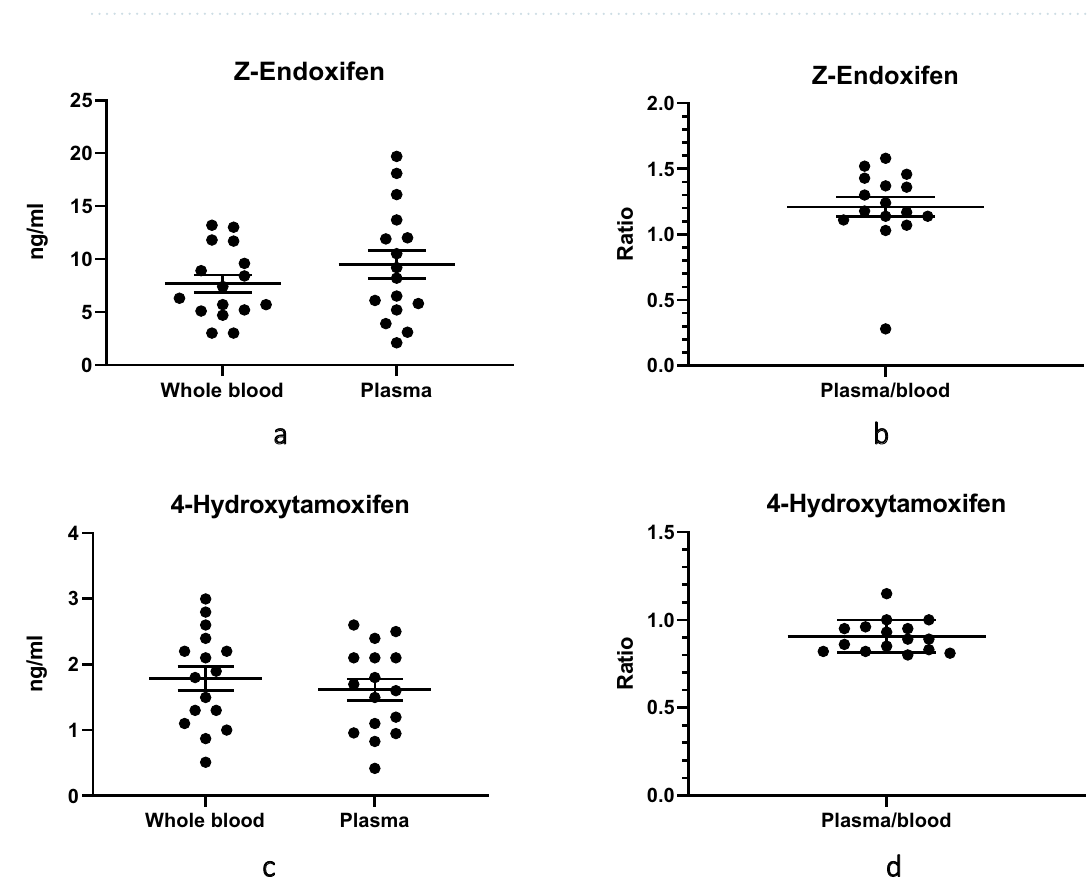
Figure 2. Z-endoxifen (END) and 4-Hydroxytamoxifen (4HT) concentrations in 16 participants with breast cancer taking tamoxifen 20 mg daily: ( a ) Distribution of END concentrations in venous blood and in plasma. The means were not significantly different ( P = 0.257); ( b ) Distribution of ratios of plasma to venous blood END concentrations; ( c ) Distribution of 4HT concentrations in venous blood and in plasma. The means were not significantly different ( P = 0.496); ( d ) Distribution of ratios of plasma to venous blood 4HT concentrations. The longer horizontal lines represent means (of concentrations or ratios), and the shorter horizontal lines represent standards of the mean